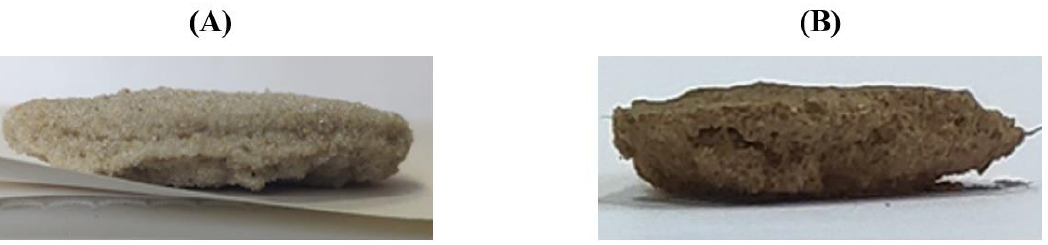
Figure 5. Photos of coatings formed on the surface of sand ( A ) and soil ( B ) after their treatment with a 1 wt.% aqueous suspension of ACP#.